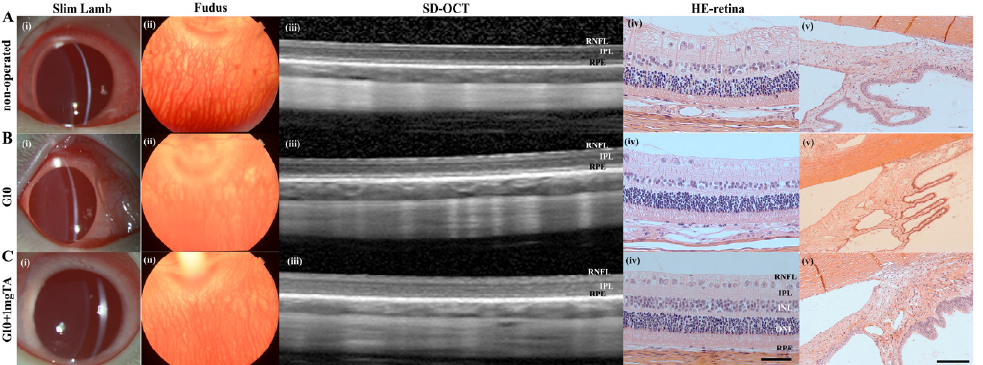
Figure 7. In vivo imaging and ex vivo retinal analysis of rabbits 2 months after implantation of GelMA hydrogels. ( A – C ), Column ( i ): slit-lamp images of operated BSS controls and G10 and G10 + 1 mg TA-injected eyes, showing no significant inflammation or cataract formation. Column ( ii ): images of the fundus revealing normal optic disc appearance and vessel morphology in all groups. Column ( iii ): SD-OCT images obtained in all four groups revealed no reduction in retinal thickness from the RPE to the RNFL. Column ( iv ): H&E histology analysis was performed in all three groups, and the results were consistent with the OCT findings (scale bars, 50 μ m). Column ( v ): H&E histological analysis of the anterior chamber angle (scale bars, 50 μ m).